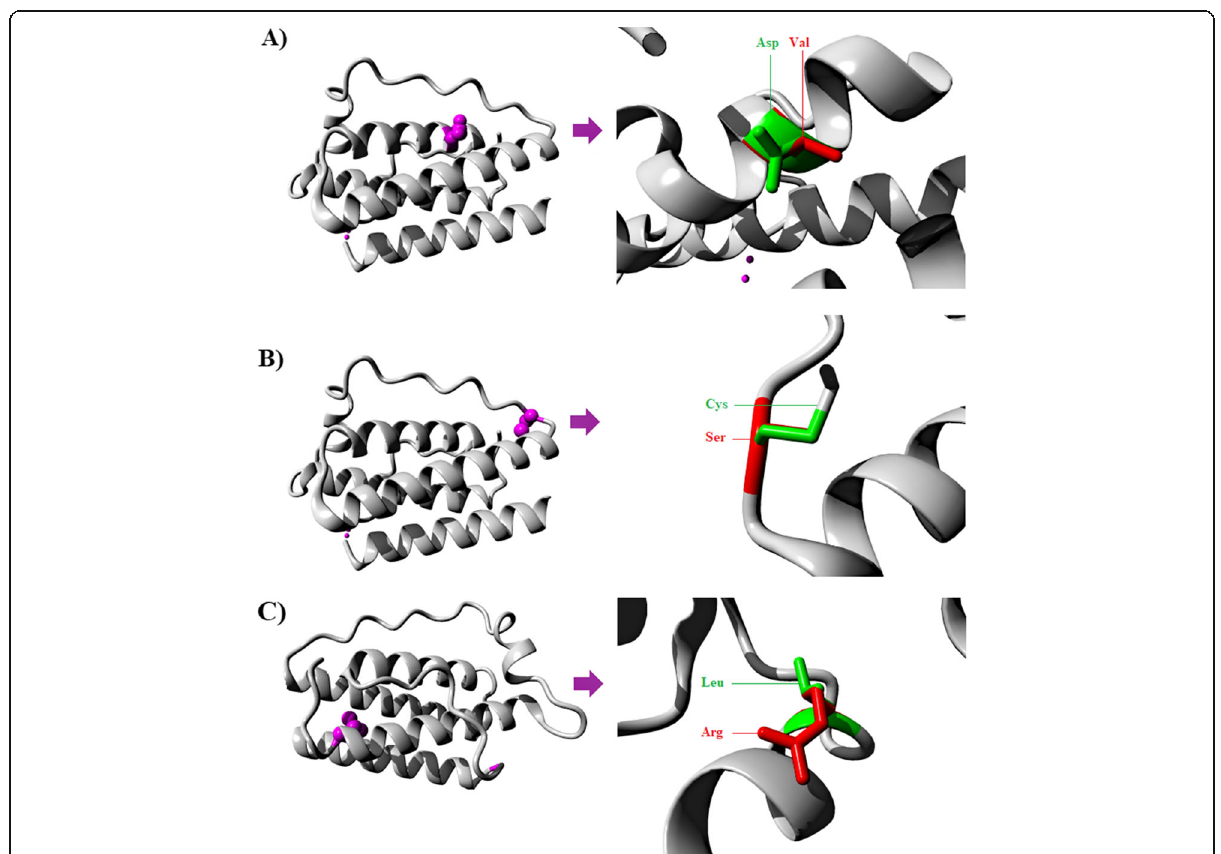
Fig. 6 The most deleterious amino acid substitutions predicted in leptin 3D structures. a ) The wild type D and the mutant V residues at 78th position (D78V). b ) The wild type C and the mutant S residues at 117th position (C117S). c ) The wild type L and the mutant R residues at 161th position (L161R). The protein is shown in ribbon-presentation and colored grey. The wild type amino acid residues affected by mutations are shown in green, while their mutant counterparts are shown in red. Structures are generated by HOPE